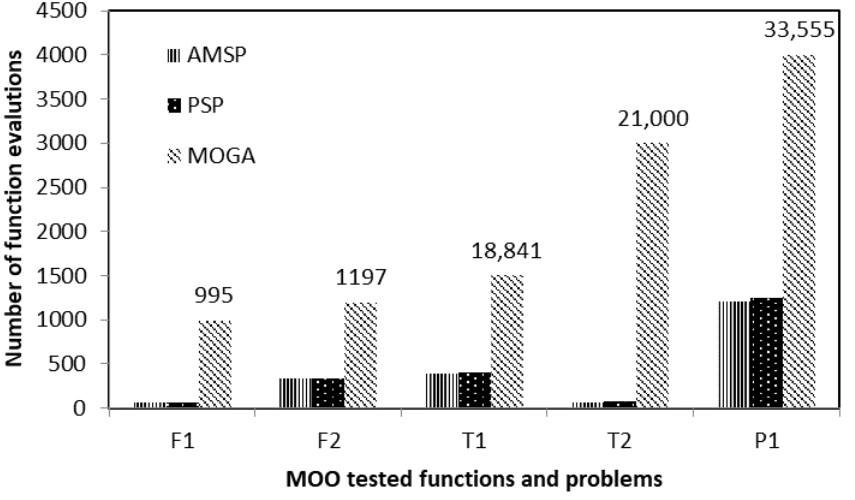
Figure 9. Performance comparison of used optimization algorithms on test problems in terms of computational